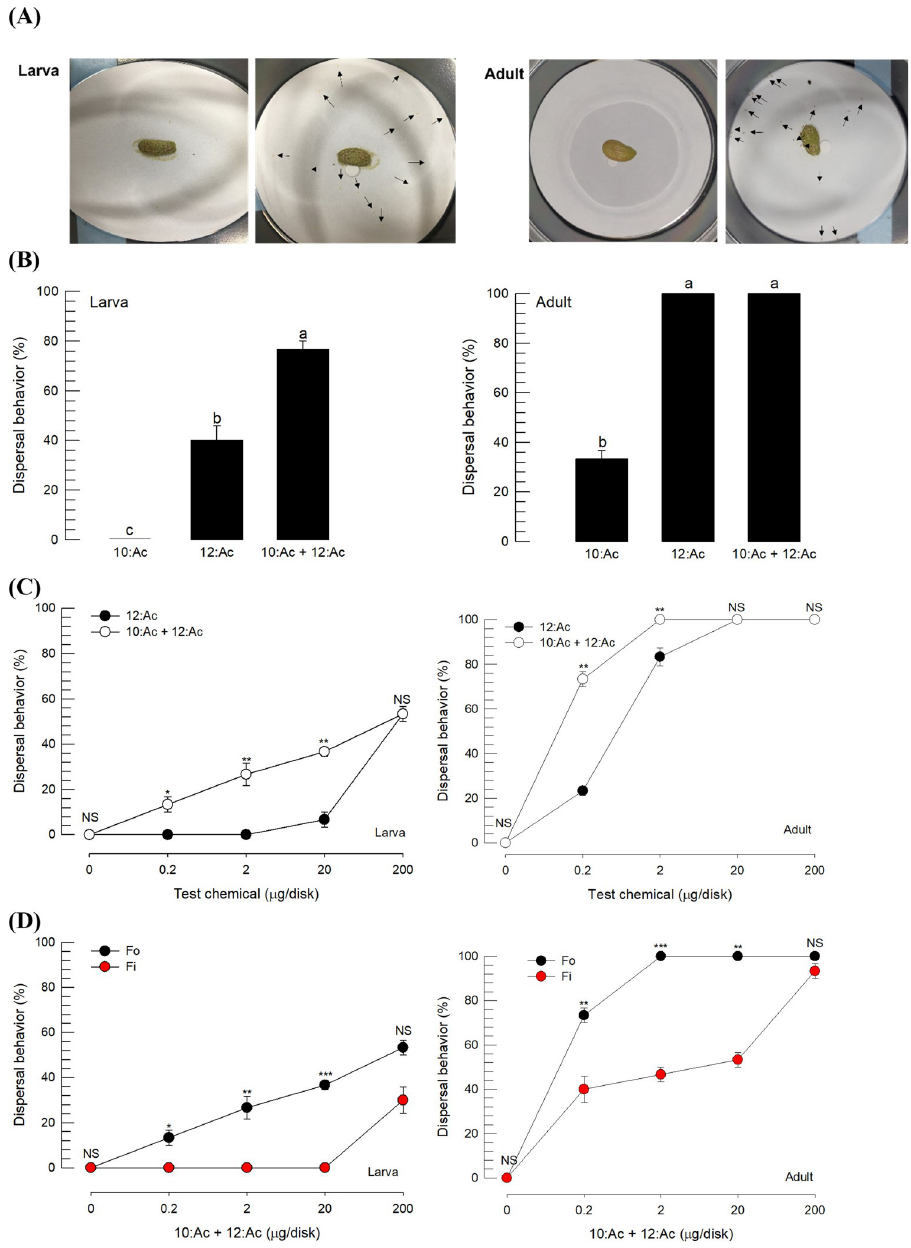
Fig 4. Development of a thrips repellent using an alarm pheromone of F . occidentalis . The alarm pheromone components were decyl acetate (10:Ac) and dodecyl acetate (12:Ac) at a 1:1.5 mass ratio. (A) Bioassay assessing repellent efficacy measured by the dispersal behavior of adults and larvae from bean diet after the test component (10 μ L) was dispensed onto a filter paper disc. Arrows indicate the dispersal behavior of larvae. Different letters above the standard deviation bars indicate a significant difference between means at type I error = 0.05 (LSD test). (B) Repellent efficacy of single and dual components. (C) Dose-response of the pheromone components. (D) Comparison of dual component pheromone (alarm pheromone) efficacy in F . occidentalis (Fo) and F . intonsa (Fi). Each treatment was replicated three times. Asterisks above the standard deviation bars indicate significant difference between two treatments (LSD test): � at Type I error = 0.05, �� at Type I error = 0.01, and ��� at Type I error = 0.0001. NS indicates no significant difference.